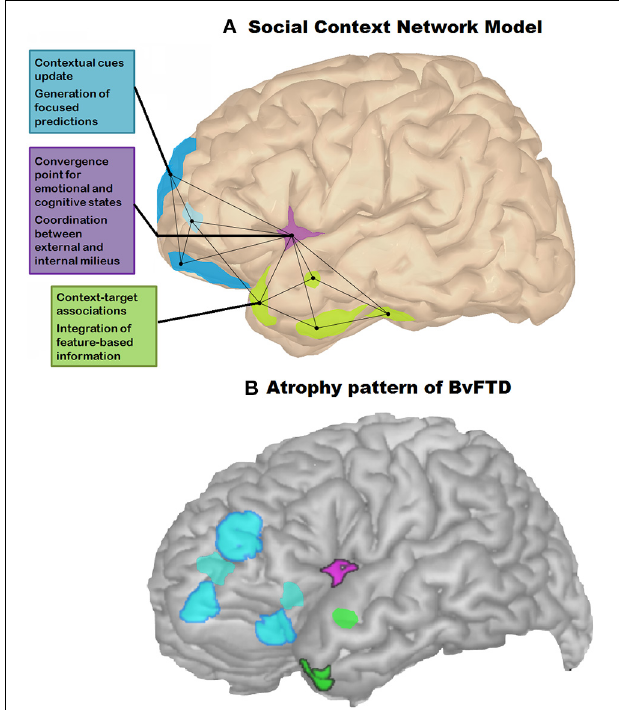
FIGURE 3 | The social context network model (SCNM). (A) Lateral view of the left hemisphere showing the fronto-insular-temporal network (light blue, violet, and green regions of interest, respectively). In this network, prefrontal areas would be involved in the generation of focused predictions by updating associations among representations in a specific context. The insular cortex would subserve the convergence of emotional and cognitive states related to the coordination between external and internal milieus. Finally, target-context associations stored in the temporal regions would be integrated with feature-based information processed in frontal regions. Connected nodes represent fronto-insular-temporal interactions. (B) Lateral view of earliest regions (frontal-insular-temporal areas) affected in bvFTD. Note the partial overlap with the nodes of the SCNM. Reprinted with permission from Ibañez and Manes